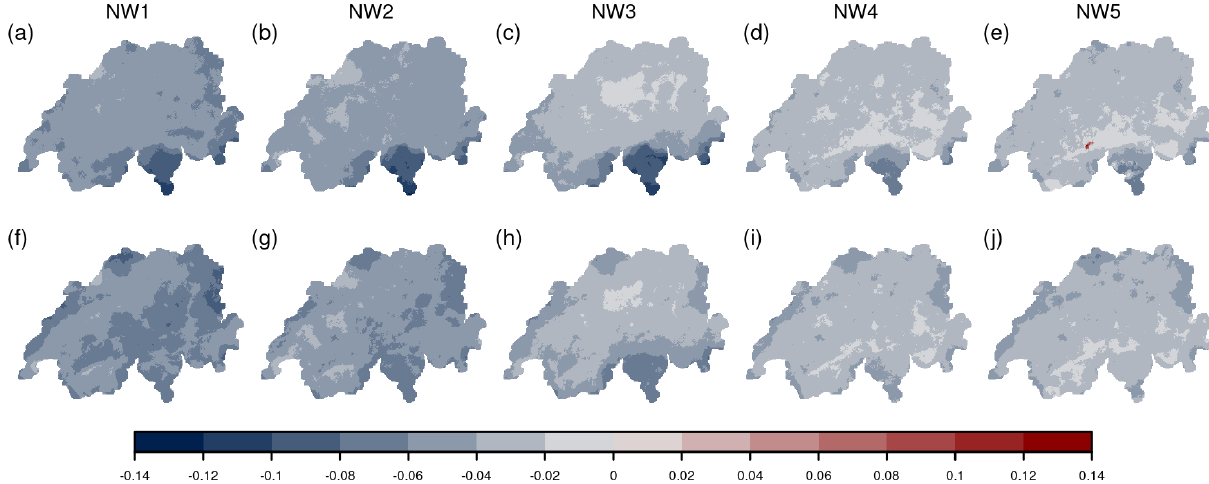
Figure A4. (a–e) Differences in the fraction of wet days followed by wet days for the cross-validations of the five networks (see Fig. 1) compared to the original data set (cross-validation minus original). (f–j) Same but for the fraction of dry days followed by dry days. A wet day is defined as a day above 0.1mm. The fractions are calculated across the entire cross-validation period of 1961 to